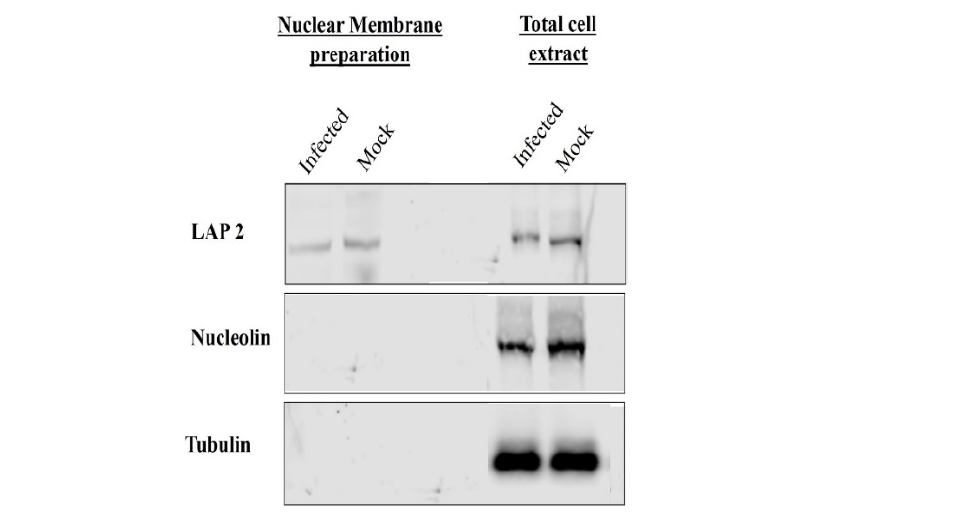
Figure 1. Nuclear membrane preparations from BoHV-1-infected and mock-infected MDBK cells were separated by SDS-PAGE on 8% reducing gels and subjected to Western blotting to check for the absence of nucleolin and tubulin, and the presence of LAP2, in the nuclear membrane. The cellular markers were detected by mouse monoclonal anti-LAP2, mouse monoclonal anti-nucleolin, and rabbit polyclonal anti-tubulin IgG, followed by IRDye 680RD goat anti-mouse IgG and IRDye 680RD goat anti-rabbit IgG, respectively.